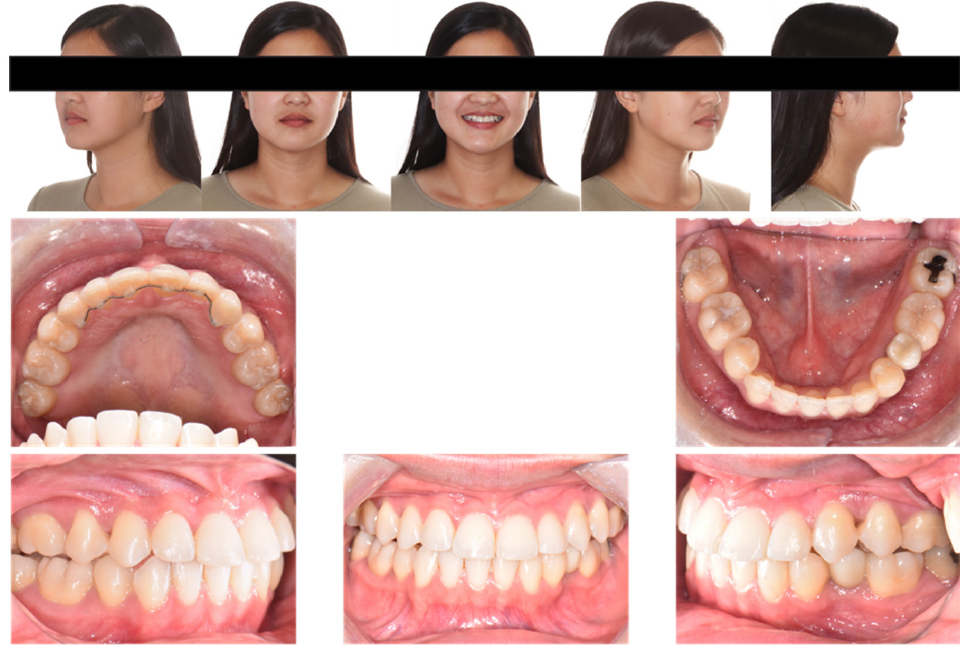
Figure 9. Posttreatment facial and intraoral photographs.